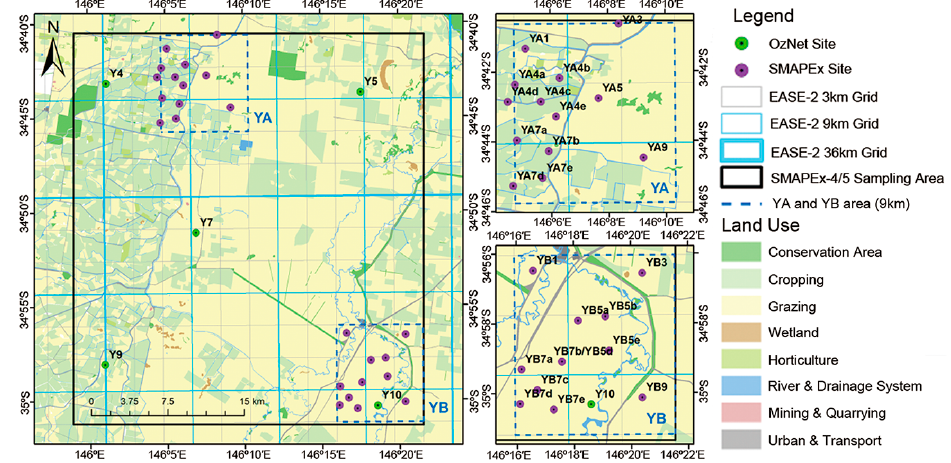
Figure 1. Location and land use of study area mapped with Equal-Area Scalable Earth (EASE) Grid-2 projection. Yanco A (YA) and Yanco B (YB) are the two primary 9 × 9 km 2 study zones. Source: SMAP Experiment (Ex)-4/5 work plan [40].